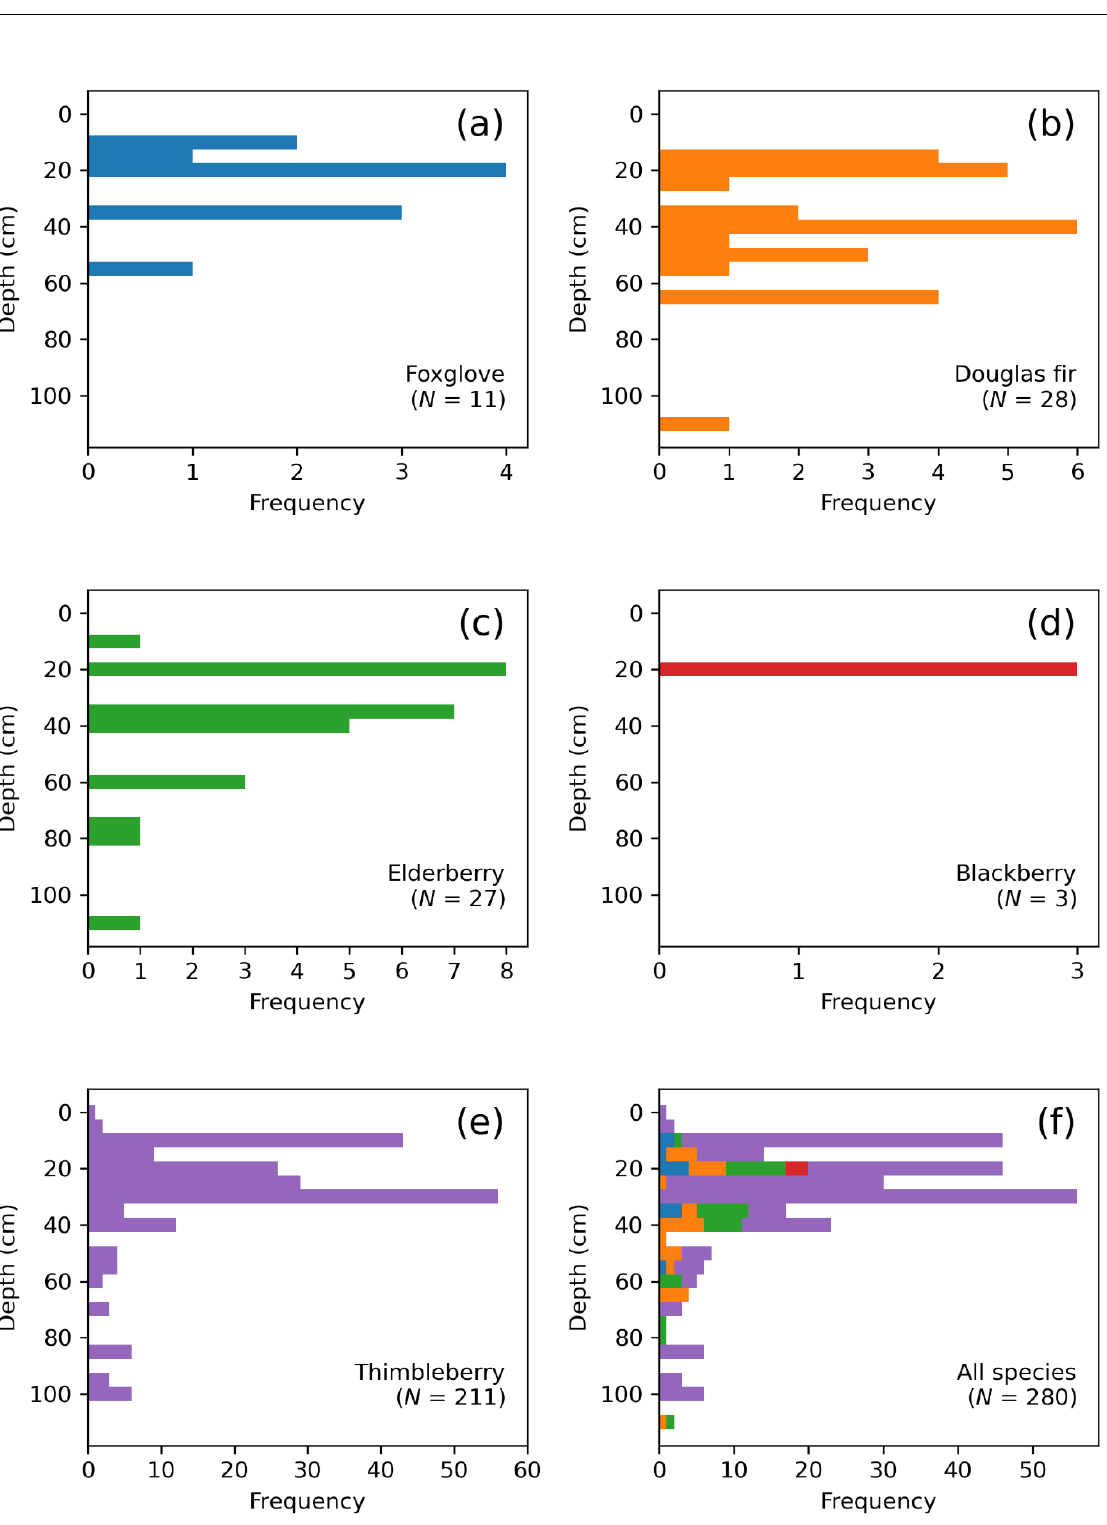
Figure 6. Histograms of depth below ground surface for the roots of each of the vegetation species identified along the landslide scarp. Histograms of depth below ground surface are shown for foxglove ( a ), Douglas fir ( b ), elderberry ( c ), blackberry ( d ), and thimbleberry ( e ). Panel ( f ) shows the histogram of depth below ground surface for roots of all species together.